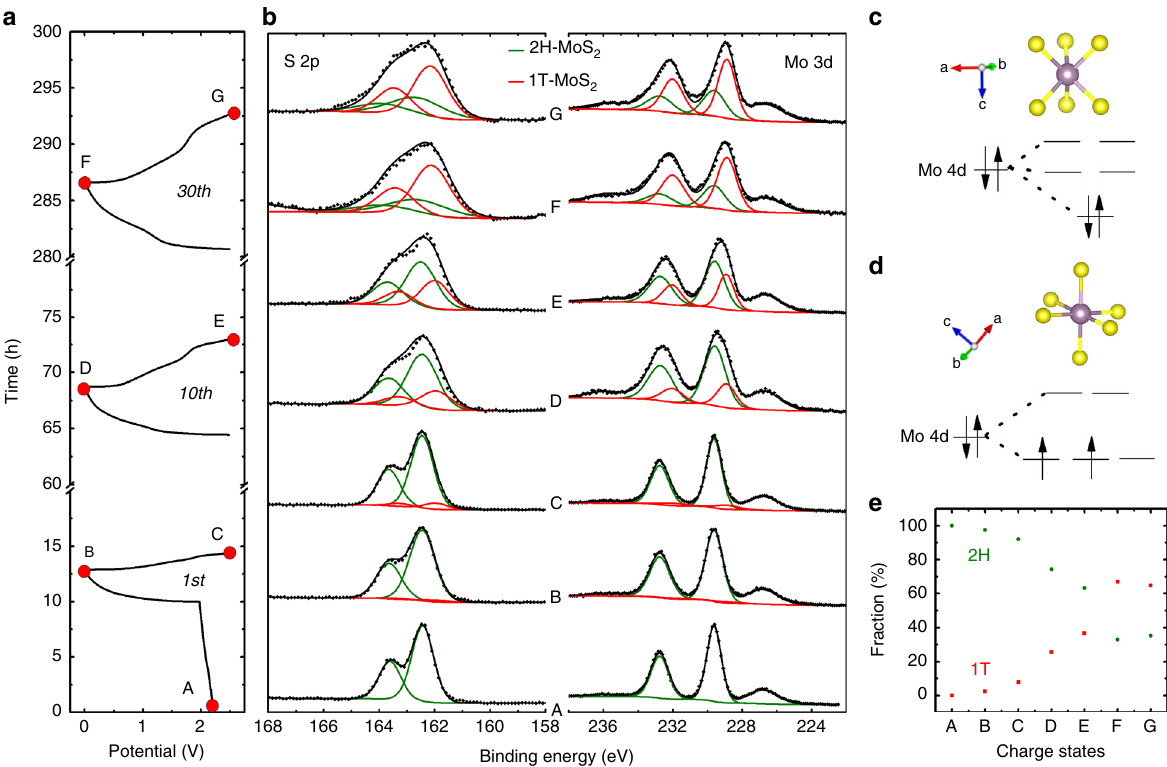
Fig. 3 Ex situ XPS measurement of MoS 2 @C-PNR electrodes. a Dis-/charge pro fi le of MoS 2 @C-PNR electrodes at selected cycles. b Ex situ XPS spectra of MoS 2 @C-PNR electrodes at speci fi c charge states indicated in the dis-/charge pro fi le. Structure and Mo 4 d orbitals of c 2H-MoS 2 and d 1T-MoS 2 . e The fractions of the two MoS 2 components at each charge